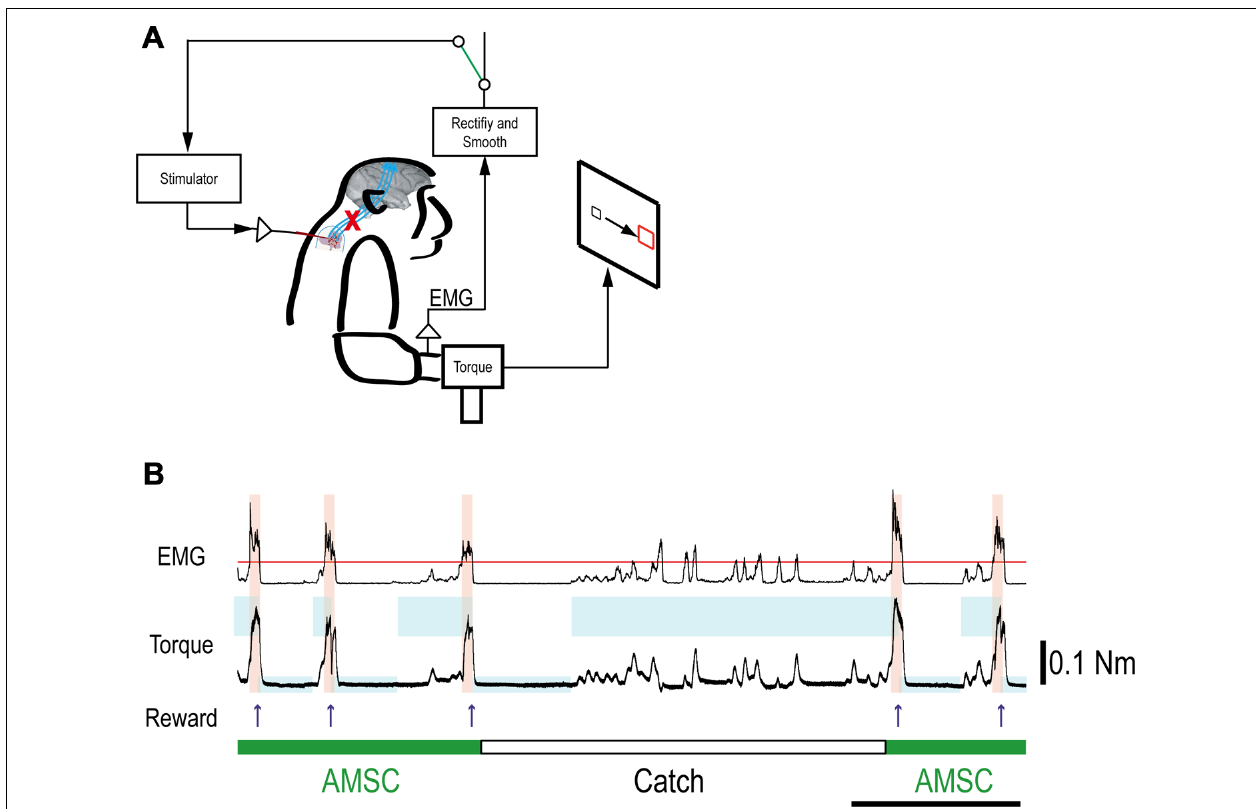
duration of electrical stimulation in the spinal site.The red line in top row represents the threshold for gating spinal stimulation.The upper and lower traces are the EMG from ECR and wrist torque generated by the monkey, during stimulation (AMSC, in green) or without stimulation (Catch, in white). Arrows indicate times of successful task completion and reward.